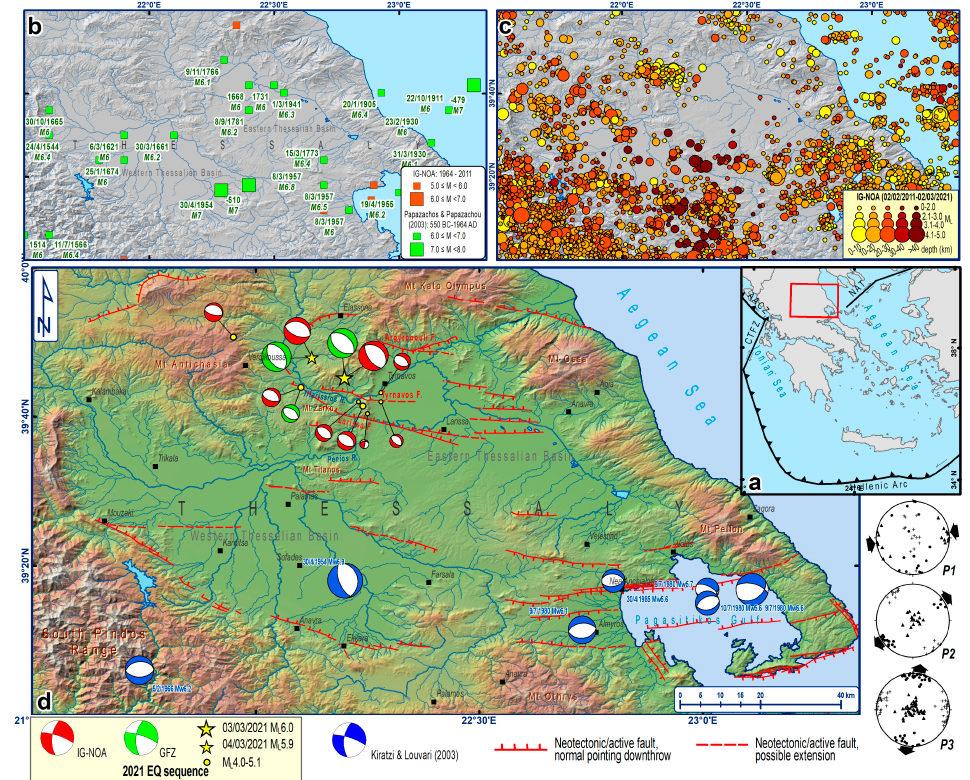
Figure 7. ( a ) Reference map. ( b ) Historically-early instrumentally (550 BC-AD 1964; [57]) and instrumentally (1964–2011) [58] recorded seismicity in Thessaly. ( c ) Recent (2011–2/3/2021) seis- micity in Thessaly [58]. ( d ) Shaded relief map of Thessaly showing the major neotectonic/active faults, and the diachronic [58] and the 2021 sequence’s [57,59] focal mechanisms; yellow stars rep- resent the two strongest earthquakes (larger star = first strongest, smaller = second strongest). The late alpine compressional (P1) and the post-alpine extensional (P2 and P3) tectonic phases after Caputo & Pavlides [9] are shown at the bottom-right. After Chatzipetros et al.